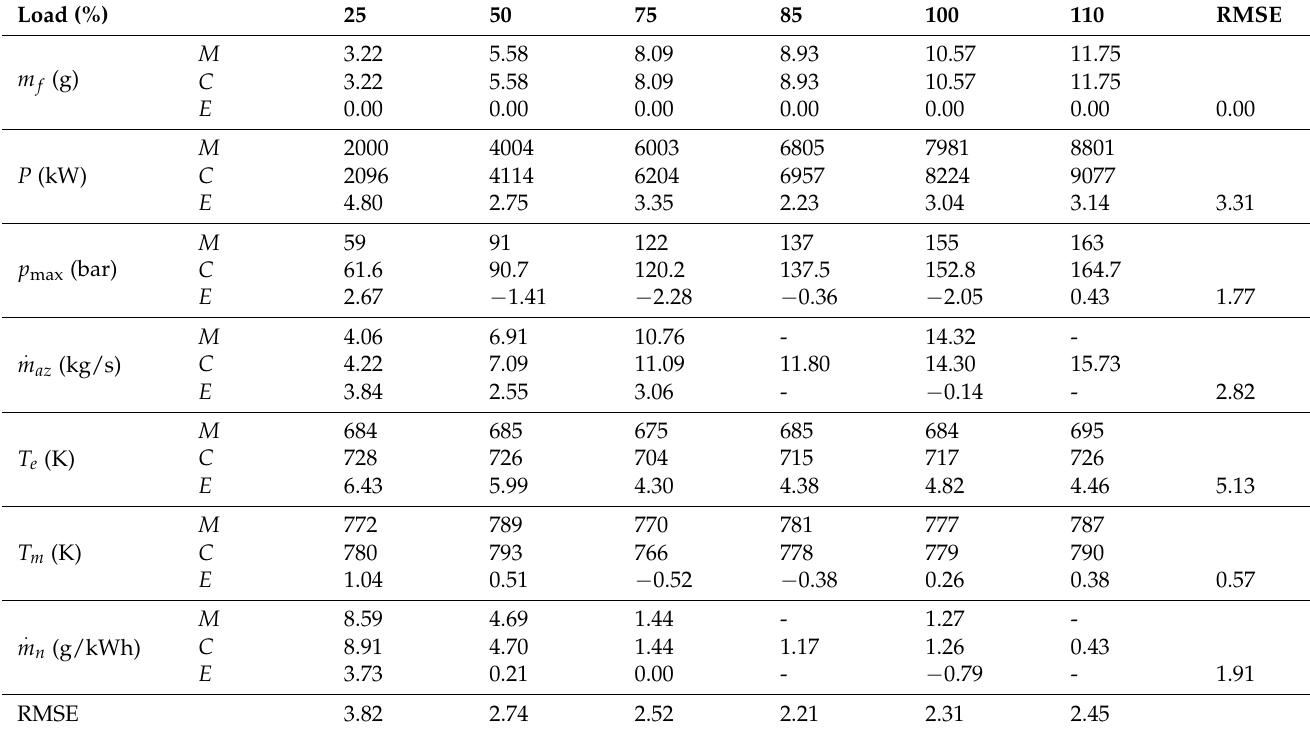
Table 7. The performance of the dual-fuel engine running in gas fuel mode with the SL